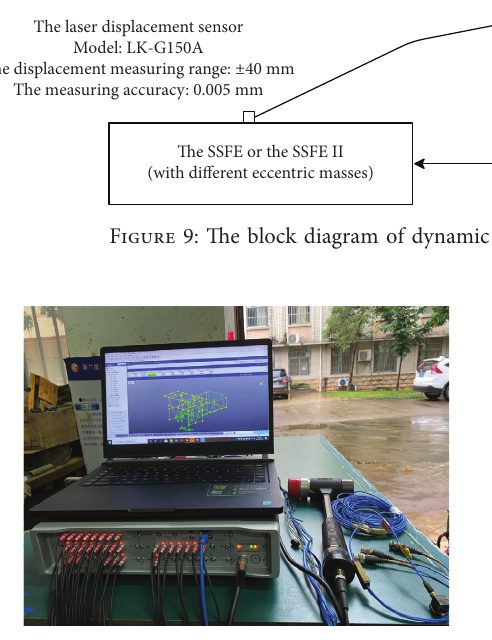
Figure 10: The LMS modal test system of the